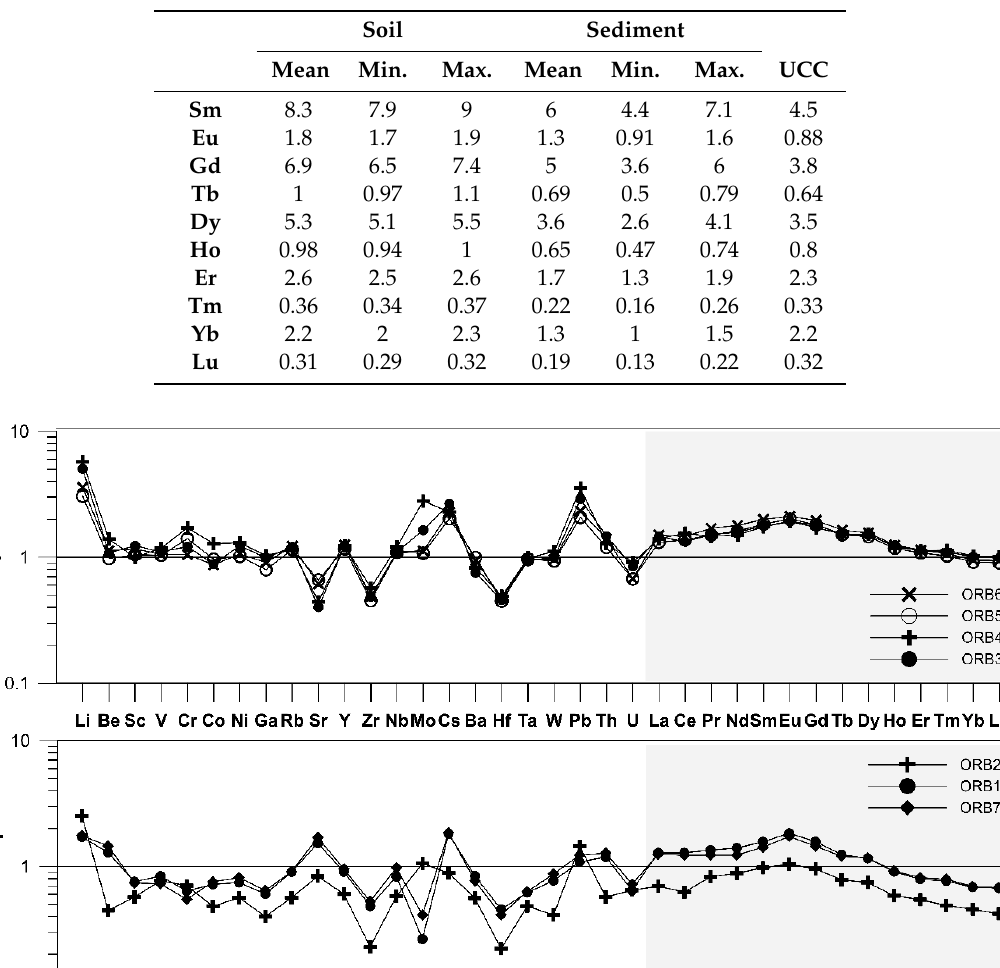
Table 4. Concentrations in mg/kg of Hg and As analyzed on two grain-size fractions.